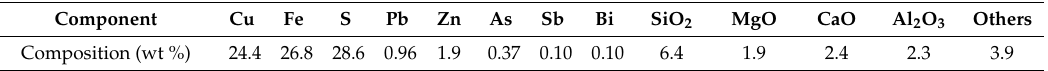
Table 4. Composition of the mixed concentrate in the furnace.